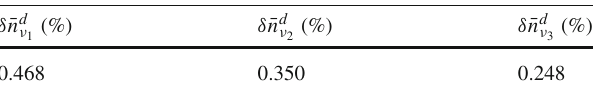
Table 1 The deviation of present number densities of neutrinos from ¯ T ( t the Fermi–Dirac distribution [ e | p | / 0 ) + 1 ] − 1 in the mass basis in